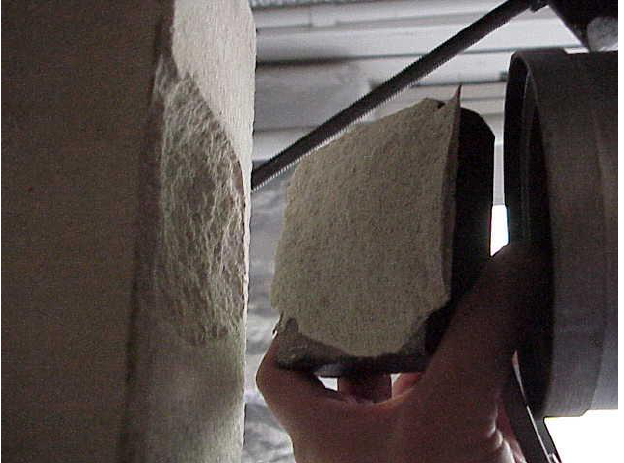
Figure 26. Plate separation from AAC wall panel during